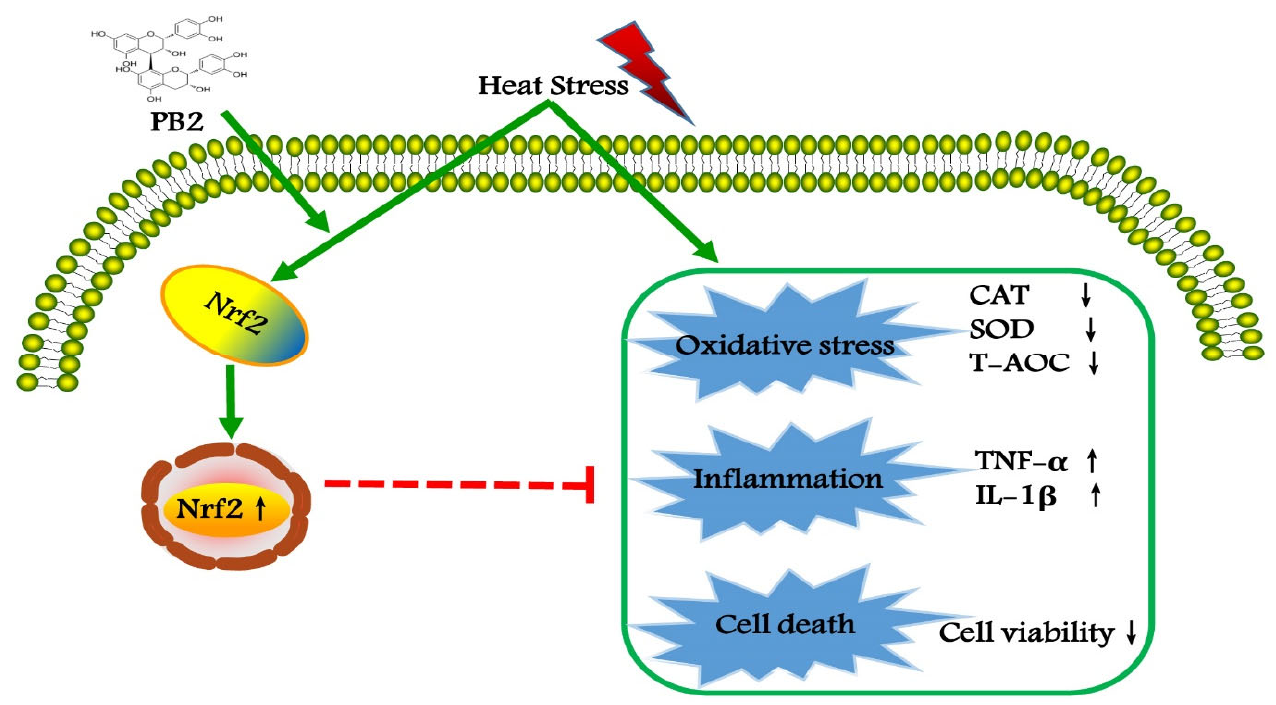
Figure 9. PB2 protects MAC-T cells against heat-induced oxidative stress and inflammatory response, predominantly via Nrf2 signaling pathway.